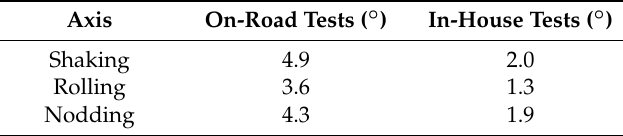
Table 2. Averaged difference of the two tracking systems between the in-house and on-road tests.